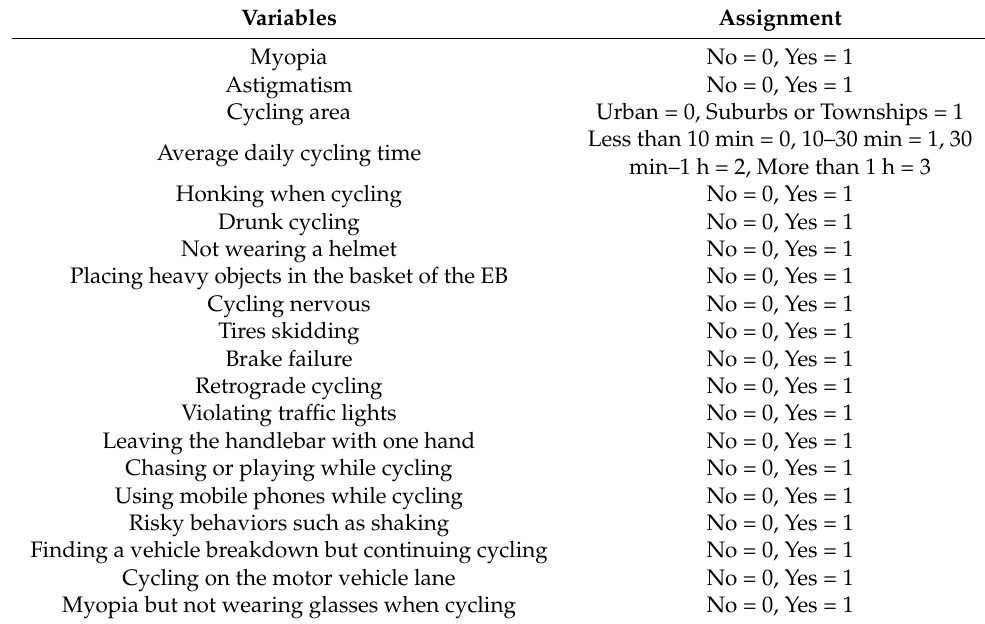
Table 3. Variable assignment for the multivariable logistic regression analysis.